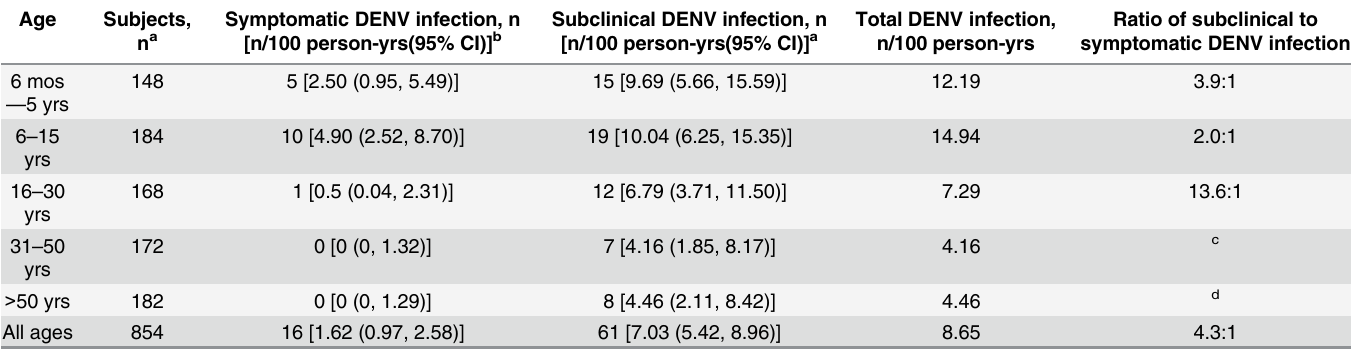
Table 2. Incidence of symptomatic and subclinical dengue virus (DENV) infections in different age groups.